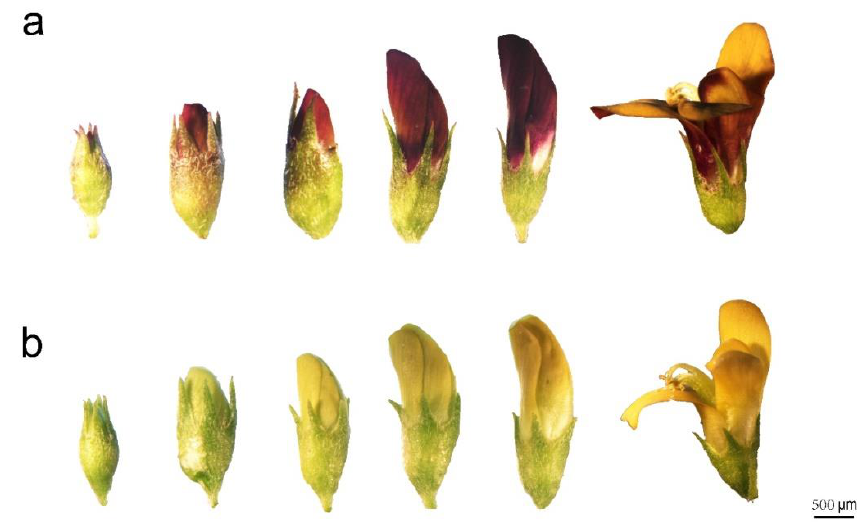
Figure 2. Development observations of M. ruthenica with different floral color phenotypes. The samples of different flower development stages were collected from PFM ( a ) and YFM ( b ) and stored at 4 ◦ C to keep them fresh. The samples were then inspected under a stereomicroscope and photographed. It takes seven days for the development and blooming of the flower tissue. The developmental process from the stage of floret includes initial separating and calyx packaging the petals, the stage of petals appearing among the calyx lobes, the stage of the petals exceeding the calyx, the stage of the petals exceeding the calyx more than 2 mm but with the vexil still wrapped by the keel, the stage of the flower ready to bloom, and finally the flower in full bloom, shown from left to right. The floral colors of PFM and YFM were stable.